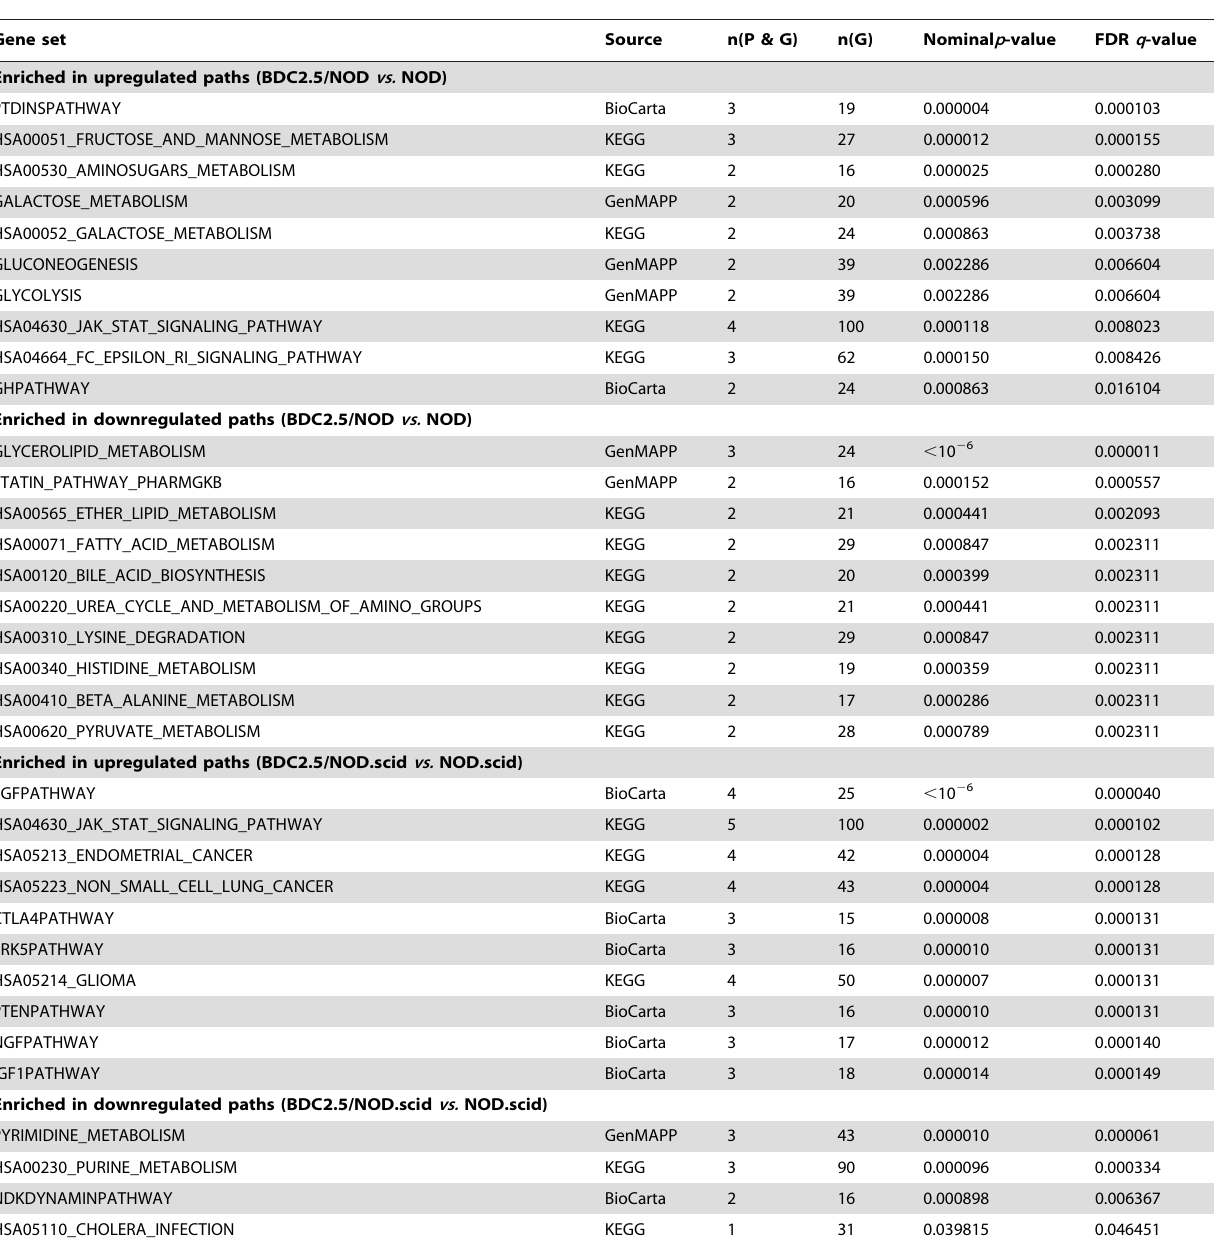
Table 1. Top enriched pathways in insulitis and type 1 diabetes as derived from detected paths.